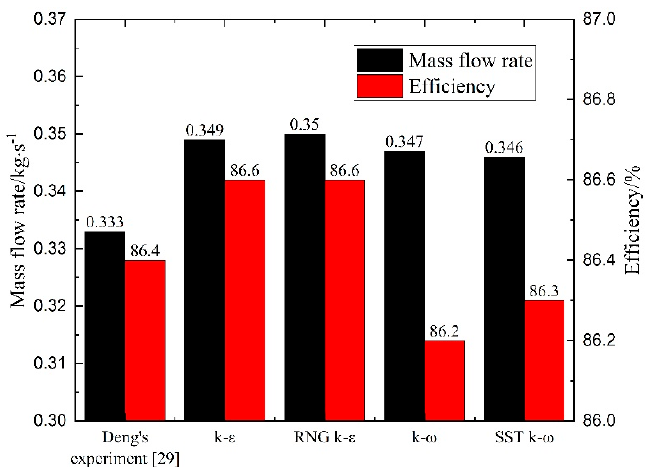
Figure 6. Validation of di ff erent turbulence models.